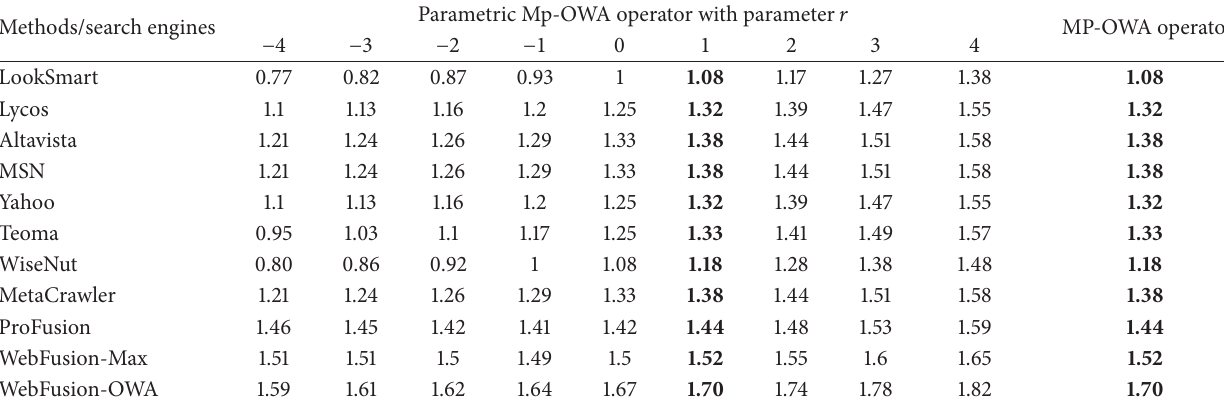
Table 6: Aggregation results given to search engines with different values of parameter 𝑟